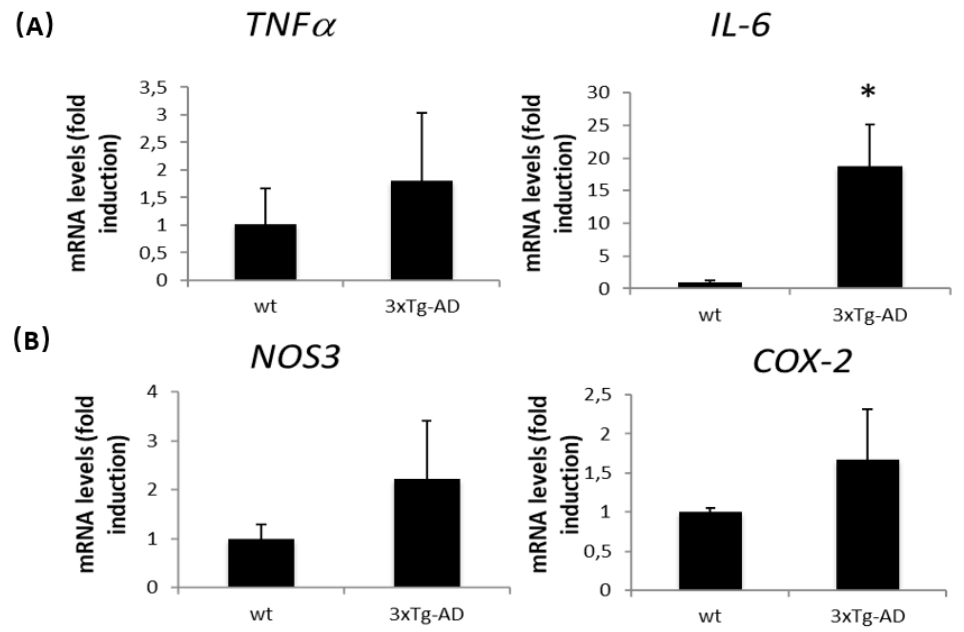
Figure 3. Inflammation and apoptosis-related gene expression in APP/BIN1/COPS5 3xTg-AD mice. TNF α ( A ), IL-6 ( A ), NOS3 ( B ), and COX-2 ( B ) mRNA levels were analyzed in wild-type ( n = 4) and APP/BIN1/COPS5 3xTg-AD ( n = 4) mice. Data are expressed as mean ± S.E.M. and as fold-changes compared to mRNA levels in wild-type mice; * p <